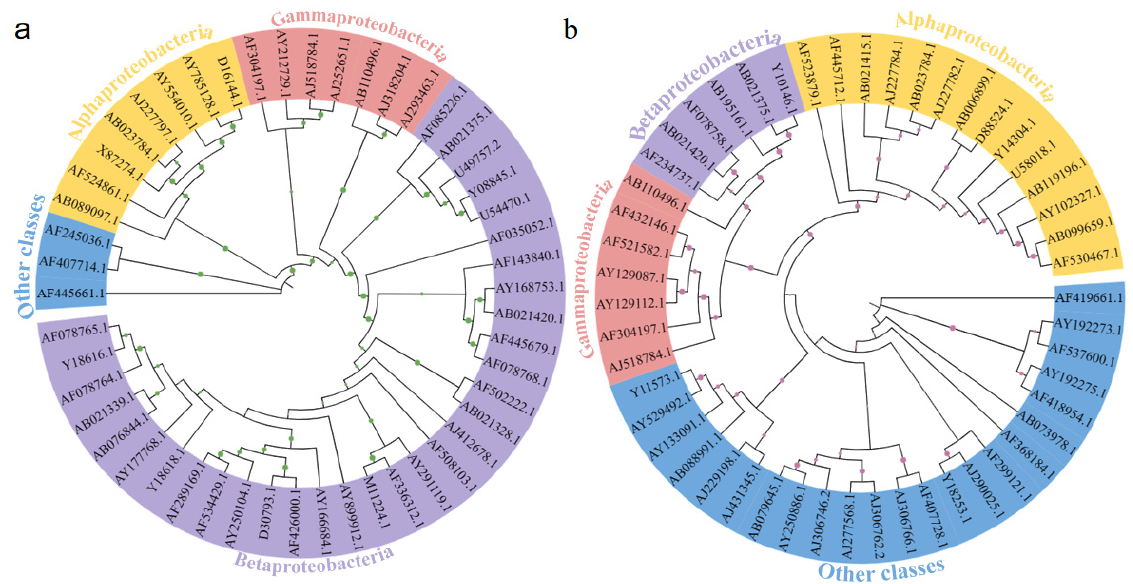
Figure 5. Phylogenetic relationships of 50 dominant universal bacterial sequences retrieved from MBfRs with different operation times: ( a ) 30 days, and ( b ) 60 days.